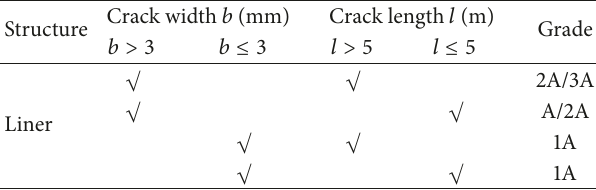
Table 1: Assessment criteria for liner crack.